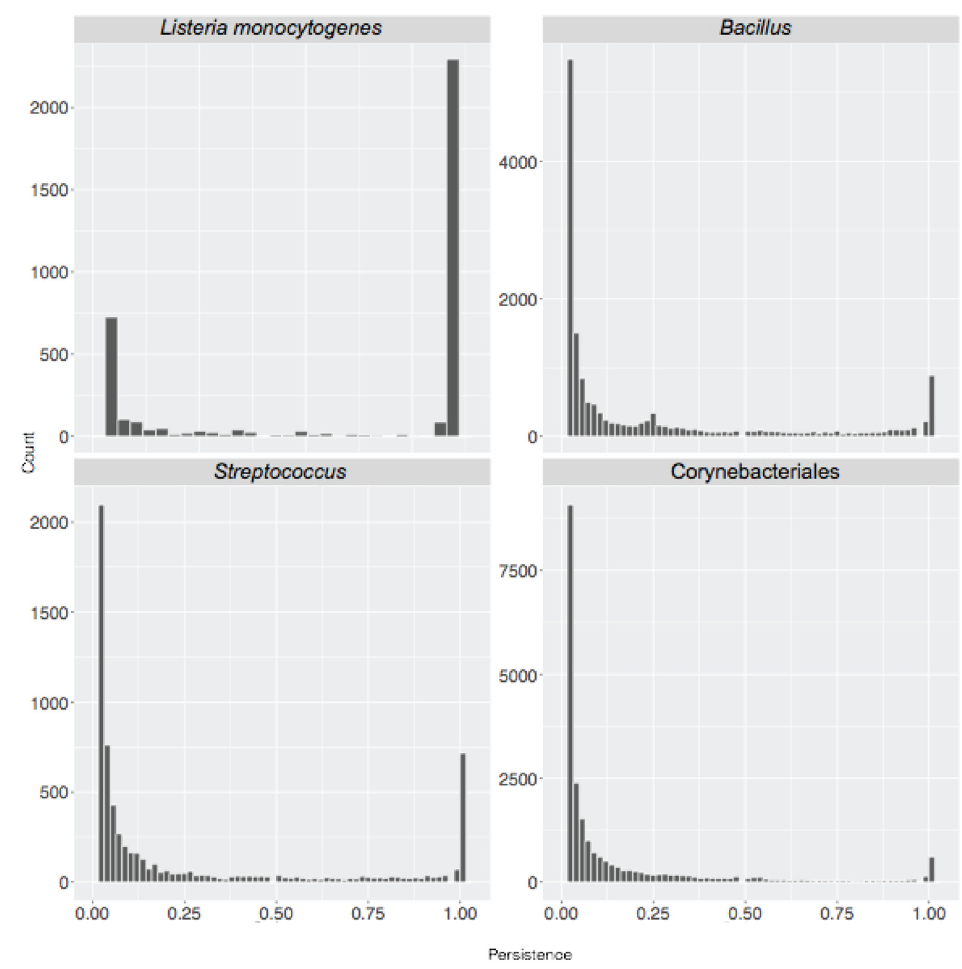
Figure 3. Persistence of sequence similarity based (SB) clusters. Cluster persistence is defined as the relative number of genomes with at least one protein assigned to the cluster. The frequency of SB clusters according to their persistence is